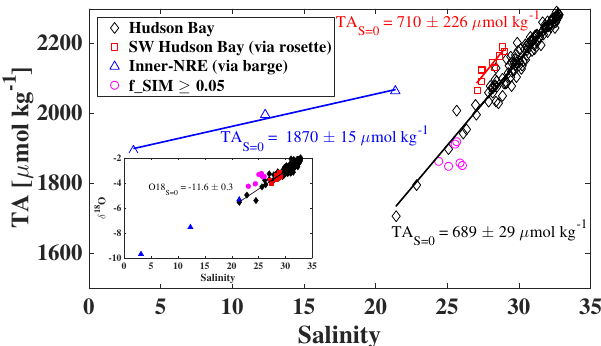
0 Figure 4. Hudson Bay TA vs. salinity ( S ) in the upper 60m of the water column (which should contain seasonal freshwater inputs; see Granskog et al., 2011). Hudson Bay stations (black diamonds, re- gression line TA = 48.8 × S + 689.2) do not include the station lo- cated northeast of the sill in the central channel (see Fig. 1). Sta- tions in southwestern Hudson Bay (red squares, regression line TA = 50.9 × S + 225.8) refer to “705” stations (see Fig. 5), and station 706 slightly further north (see Fig. 1), while inner Nelson River estuary stations (“Inner-NRE”; blue triangles, regression line TA = 9.3 × S + 1870.0) refer to “B” stations shown in Fig. 5. River- ine end-members (TA at zero salinity, or TA S = 0 ) and their corre- sponding uncertainties are calculated using linear least-squares re- gression and the error associated with the linear fit, respectively. Inset: Hudson Bay δ 18 O vs. salinity with same sample legend as the main figure (symbols are filled for clarity). The regression line ( δ 18 O = 0.3 × S –11.6) is placed through Hudson Bay samples. It is important to note that, for some surface water samples, δ 18 O and its corresponding salinity were collected independently of TA and its corresponding salinity; therefore, high f _SIM (calculated using δ 18 O) may not be present in TA samples. This may explain why some samples with high f _SIM show little to no negative deviation in TA (purple